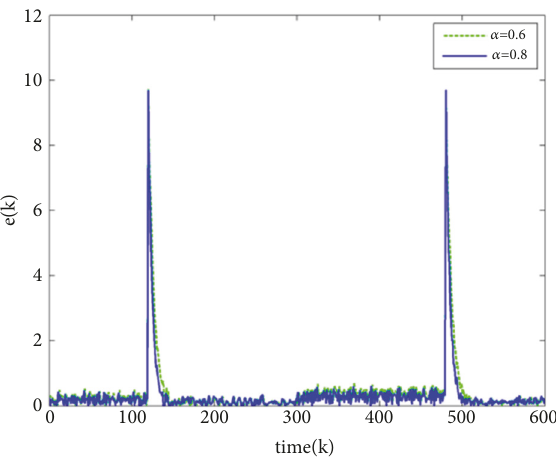
Figure 5: Output tracking error under constant fault.